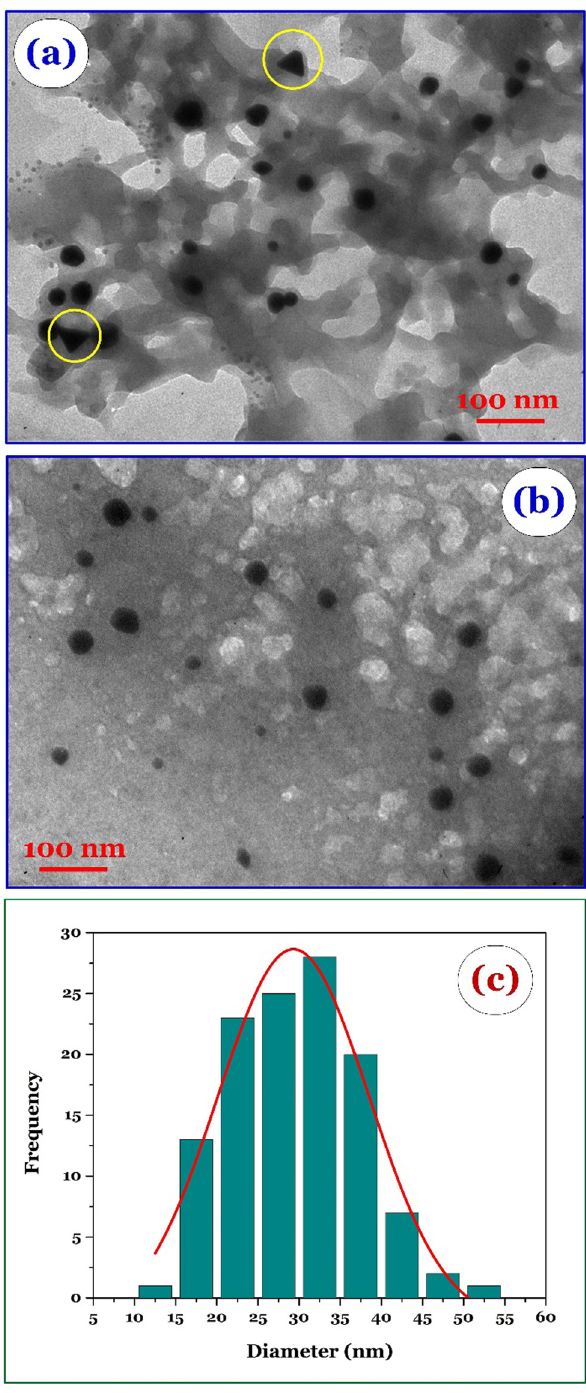
Figure 4: ( a and b ) TEM images of Au - NPs - 3.75% and ( c ) distribution of its particle